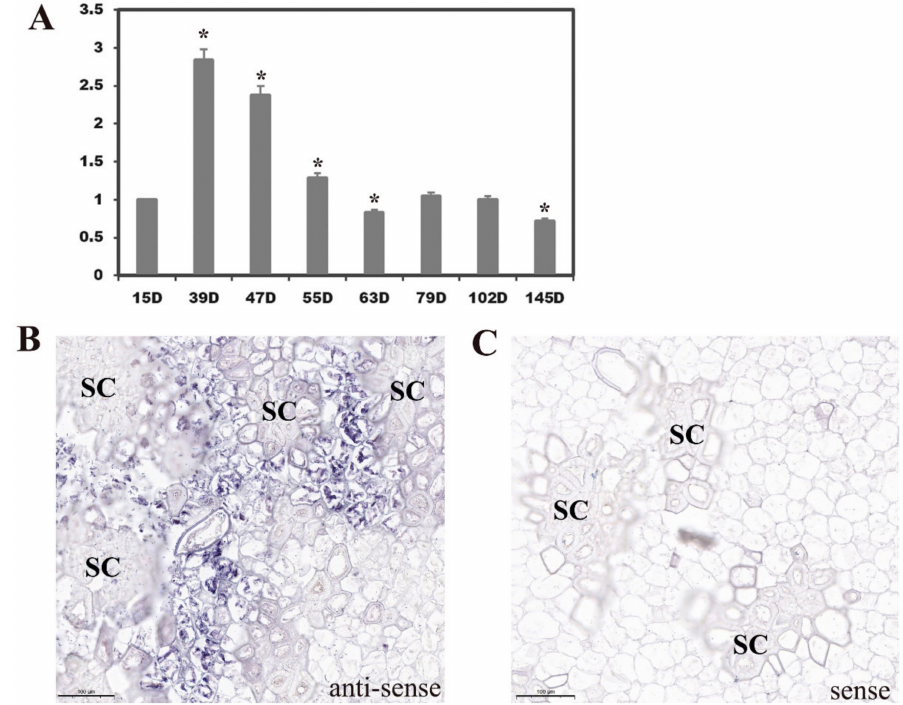
Figure 3. RT-qPCR analysis of PbUGT72AJ2 in pear fruits different developmental stages and RNA